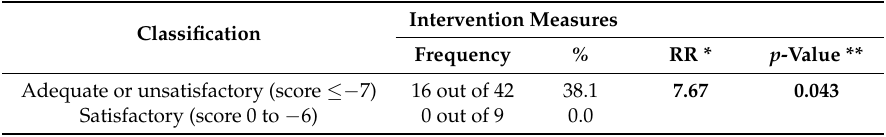
Table 1. Hygiene inspection classification score and need for intervention measures according to European Working Group for Legionella Infections (EWGLI) criteria. RR—relative risk.